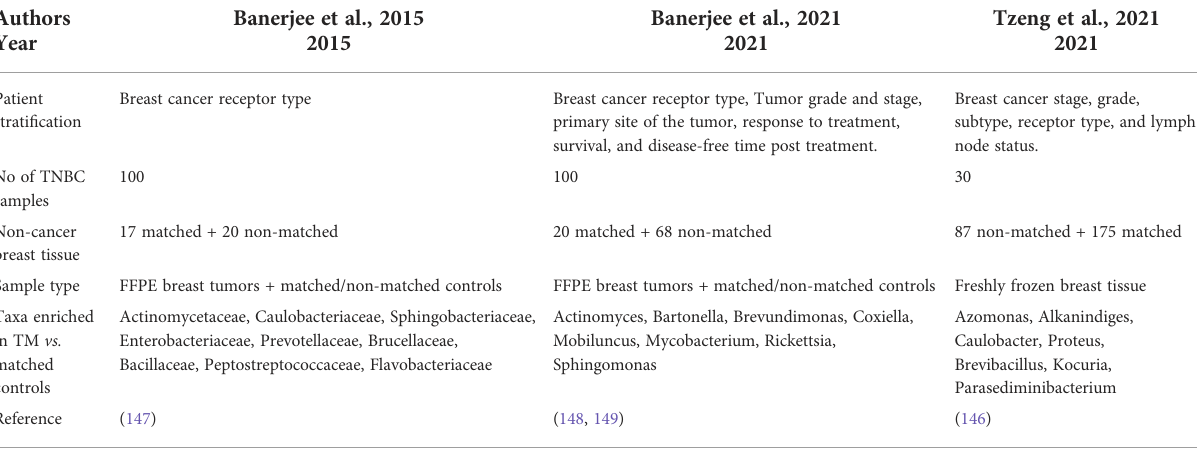
TABLE 1 Description of studies of the TNBC